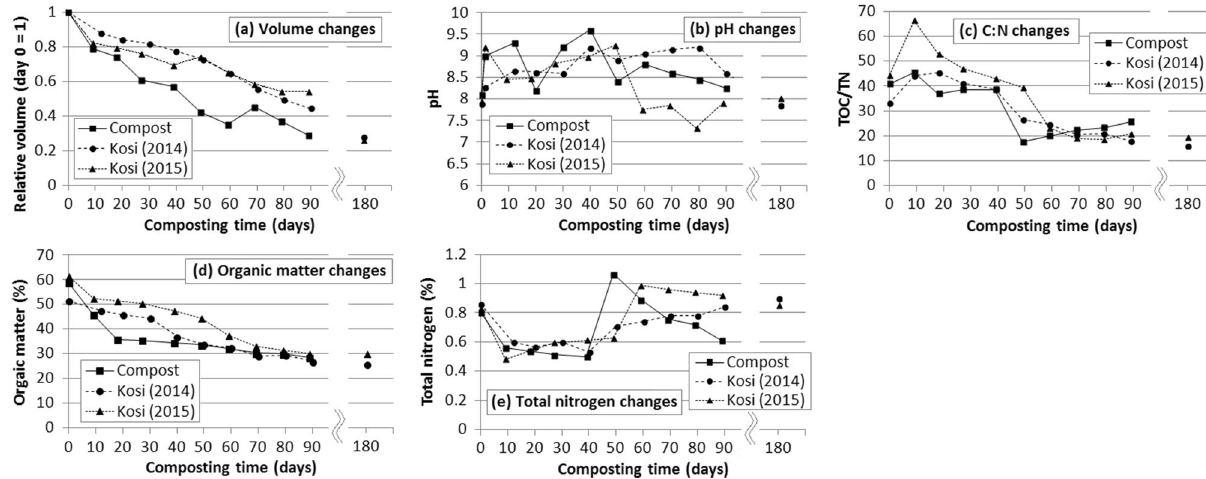
Figure 4. Changes in pile volume ( a ), pH ( b ), C:N ratio ( c ), organic matter contents ( d ), and total N ( e ) of the 2014 and 2015 kosi piles and the fast compost pile during the composting process. Mean values were plotted. C:N ratio carbon (C):nitrogen (N) ratio, TOC total organic carbon, TN total